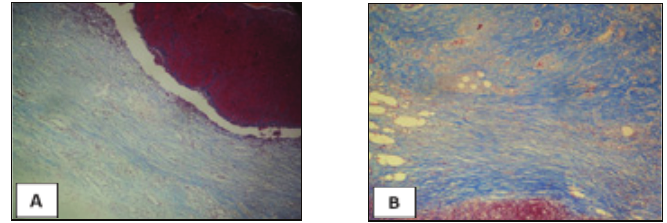
FIGURE 3 - Histological sections of the appendiceal wall, stained with Masson’s trichrome (100X), with mild fibrosis in the specimen without induced appendicitis treated with simple ligation ( A ), compared with the specimen B , with moderate to marked degree of fibrosis in animal induction of appendicitis treated with LigaSure TM